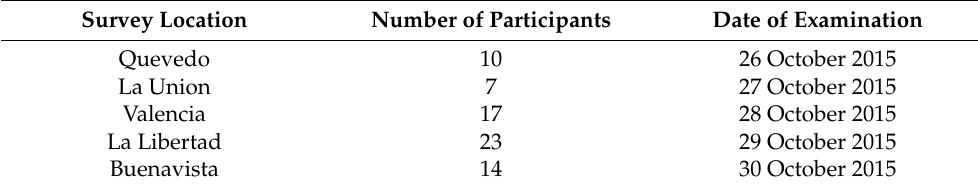
Table 1. Overview of survey locations and number of